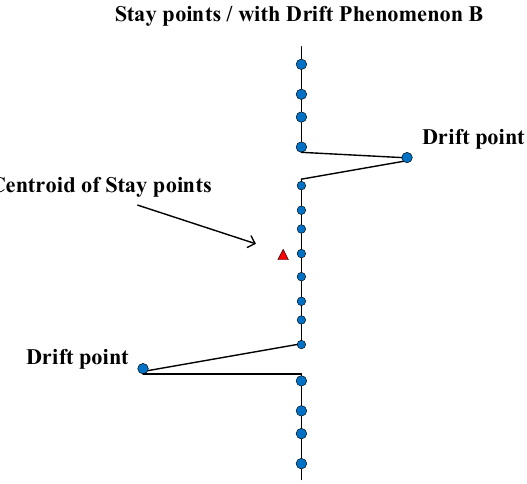
Figure 11. Error and accuracy calculations with the stay points and drift point.